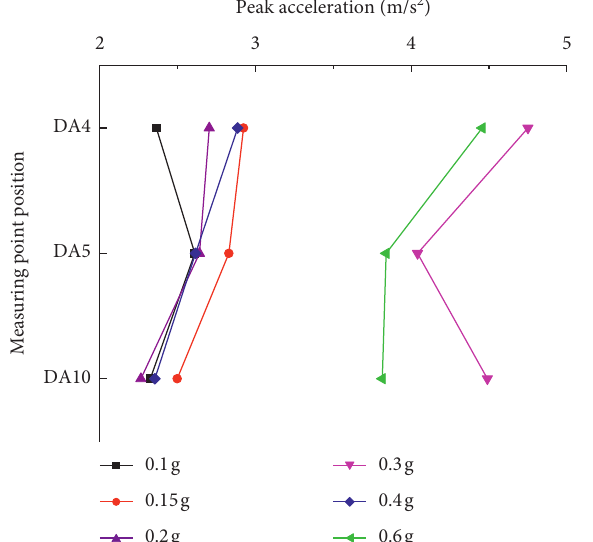
Figure 10: Peak acceleration at different measuring points of bridge pile on mountainside.